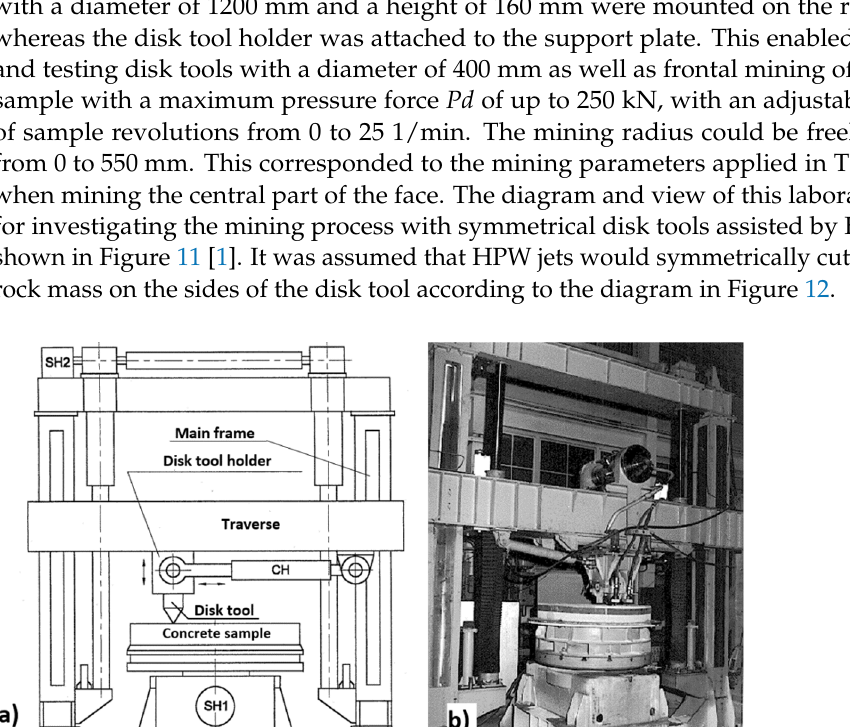
Figure 11. The test stand for testing single tools, preparing to mine the concrete sample with a disk tool with high pressure water jet assistance: ( a ) the scheme, ( b ) photo [1].